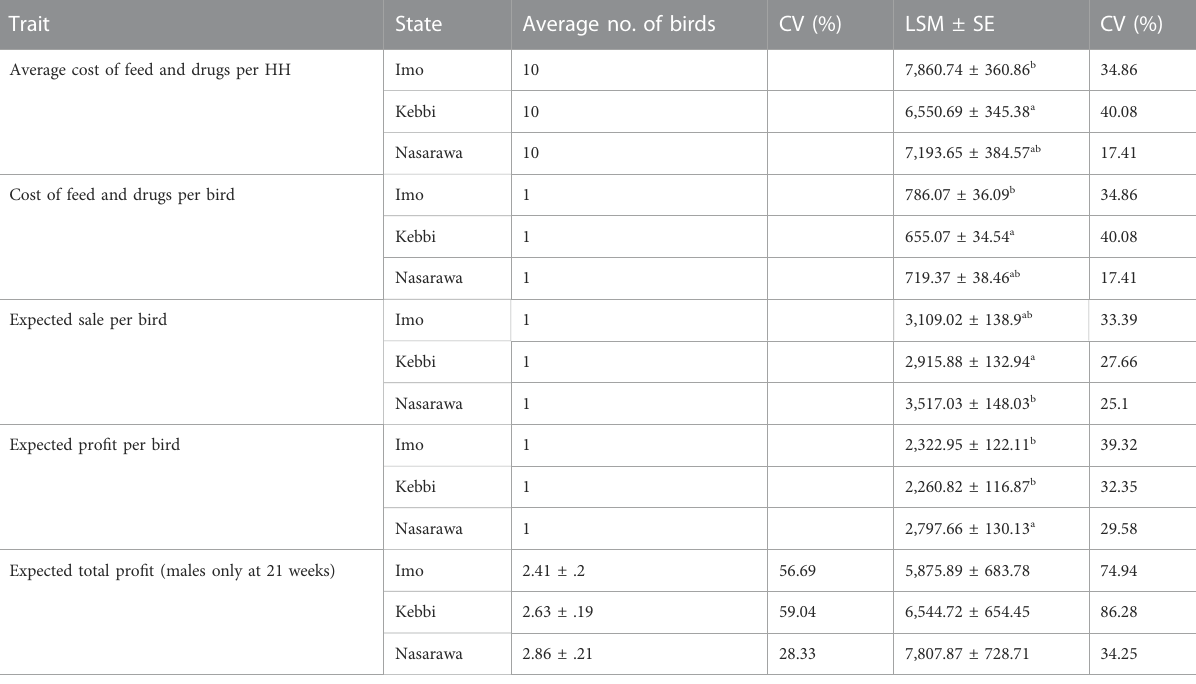
TABLE 8 Effect of agro-ecological zone on pro fi tability (LSM ± SE) of the improved smallholder chicken intervention.